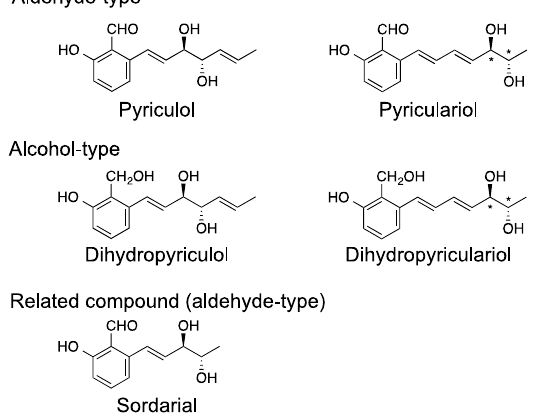
Figure 3. Structures of the pyriculols and a related compound.